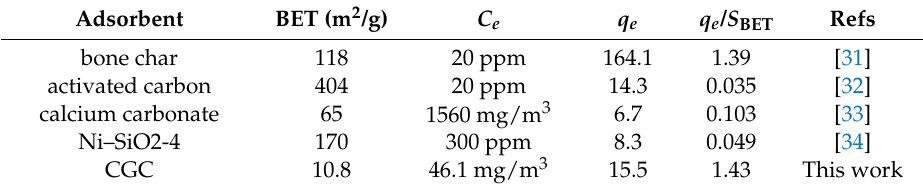
Table 3. Equilibrium HCHO adsorption amount per unit BET area of the adsorbents.